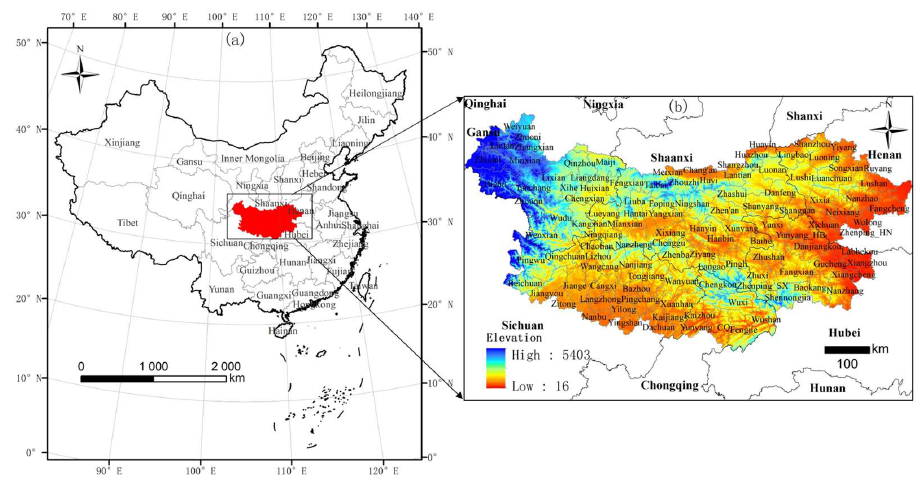
Figure 1. Geographical location map of the Qinling-Daba Mountains. ( a ) The location of the Qinling- Daba Mountains in China ( b ) The location and elevation of 120 counties and the corresponding six provinces.